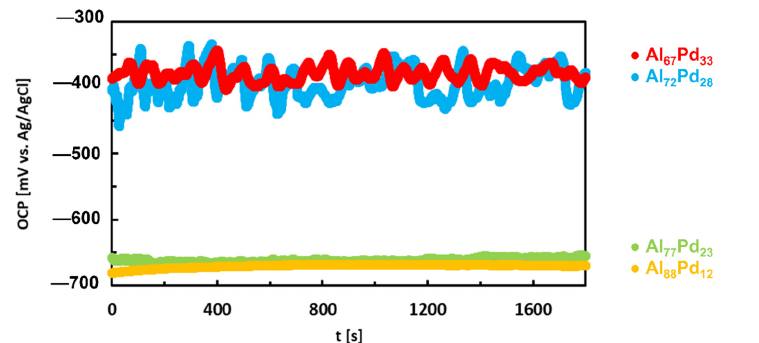
Figure 17. Open circuit potentials of Al–Pd alloys in aqueous NaCl, re-plotted from data in refer- ence [105].